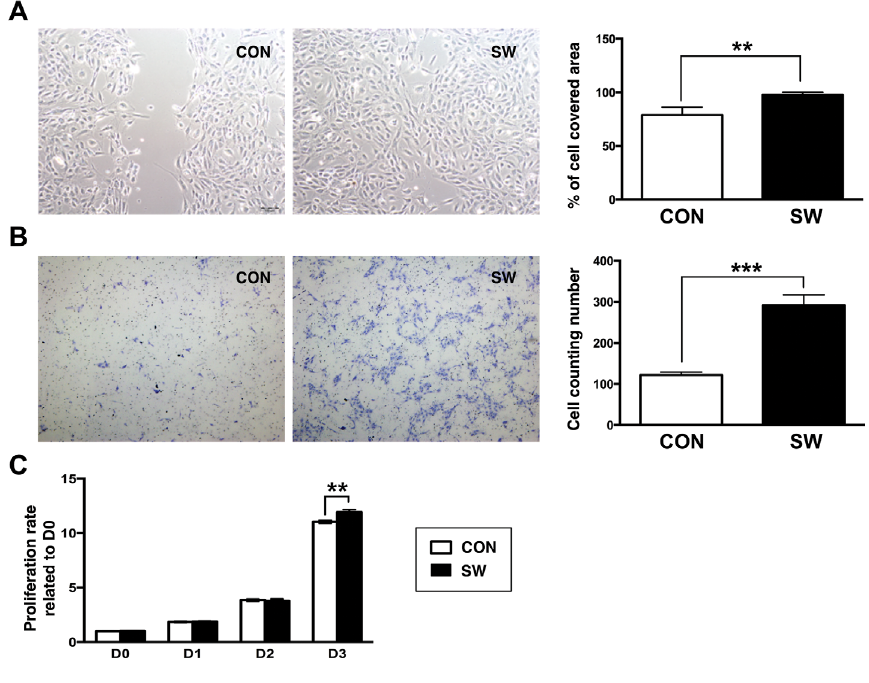
Figure 3. Enhancement of cellular migration and proliferation by shock wave (SW) treat- ment. (A) Representative images of wound healing assay without (CON) and with SW treatment. Computation of cell-covered area by WimScratch image analysis for cell motility determination (n = 4 in each group). (B) Representative images of transwell migration assay without (CON) and with SW treatment. Counting of hematoxylin-stained migrated cells by ImageJ for the cell motility determination (n = 5 in each group). (C) For cellular proliferation determination, HUVECs collected from d 0 to d 3 post-SW treat- ment subjected to MTT assay (n = 4 in each group/per d). Data shown as means ± S.D. * P < 0.05, ** P < 0.005, *** P < 0.0005 by Student t